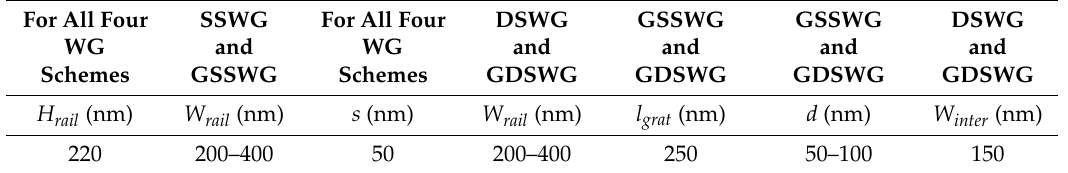
Figure 1. Schematic of ( a ) Single slot waveguide, ( b ) Double slot waveguide ( c ) Subwavelength grating single slot waveguide, ( d ) Subwavelength grating double slot waveguide. Table 1. Geometric parameters of WGs.